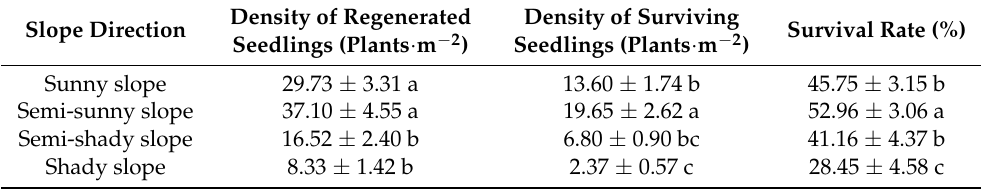
Table 6. Seedling demography of Castanopsis hystrix on different slope directions. Slope